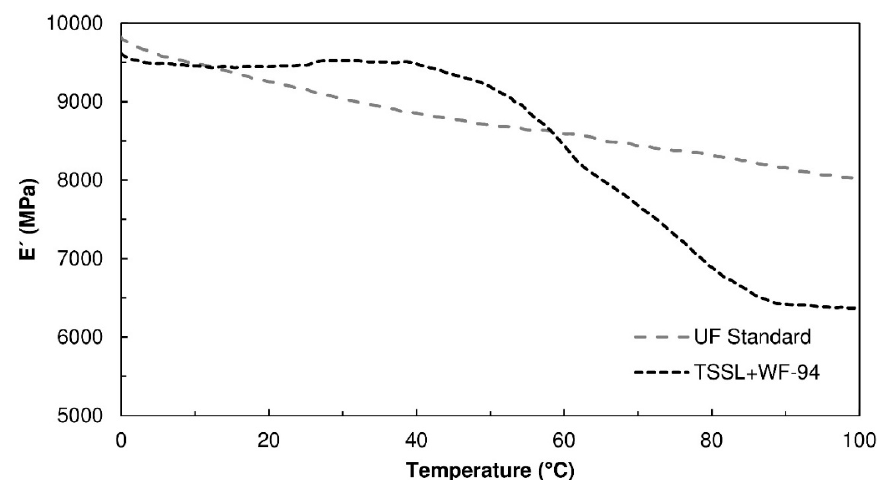
Figure 5. Storage modulus ( E ’) variation as a function of temperature, of beech wood joints bonded with a urea-formaldehyde (UF) standard resin and TSSL+WF-94 binder.